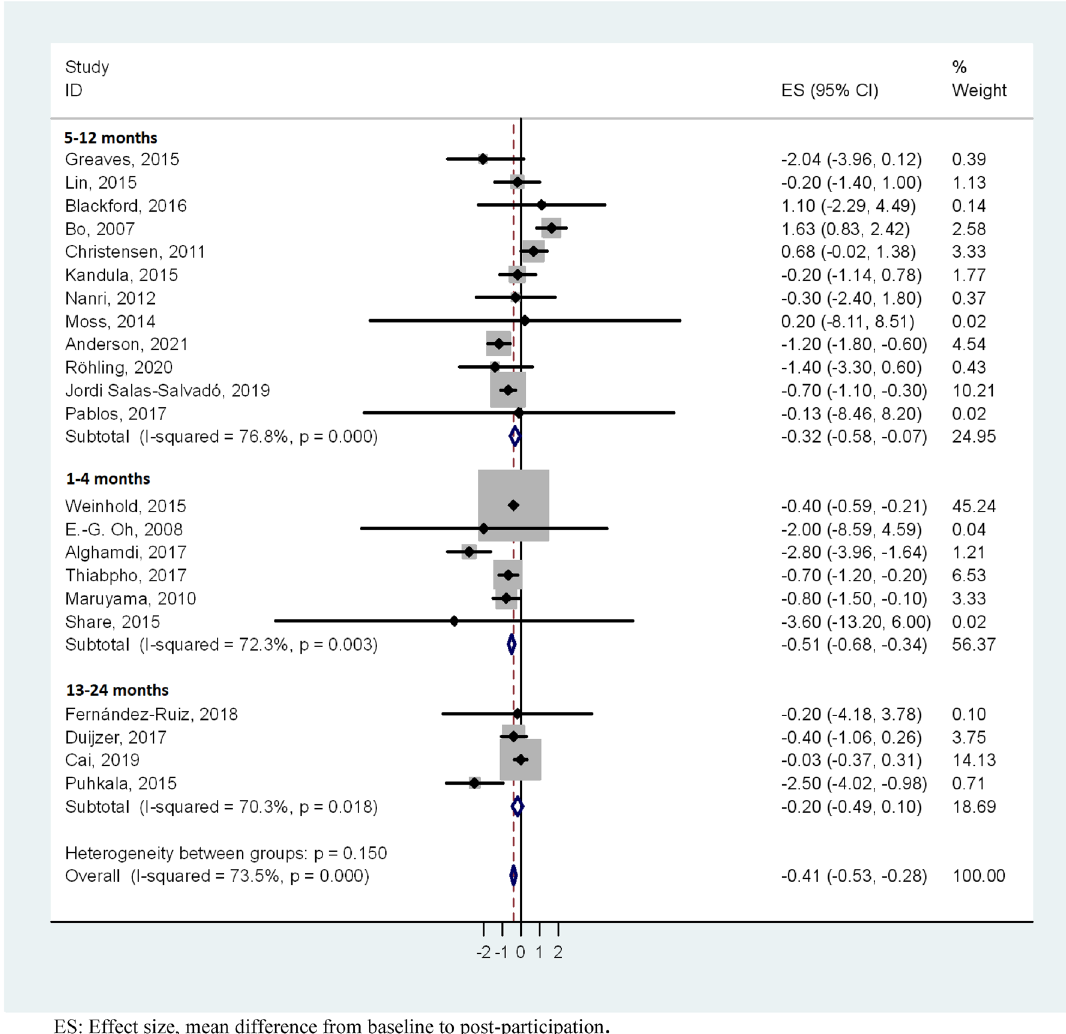
Figure 4. Meta-analysis of weight loss outcome in control group participants stratified by duration of follow-up in lifestyle randomized controlled